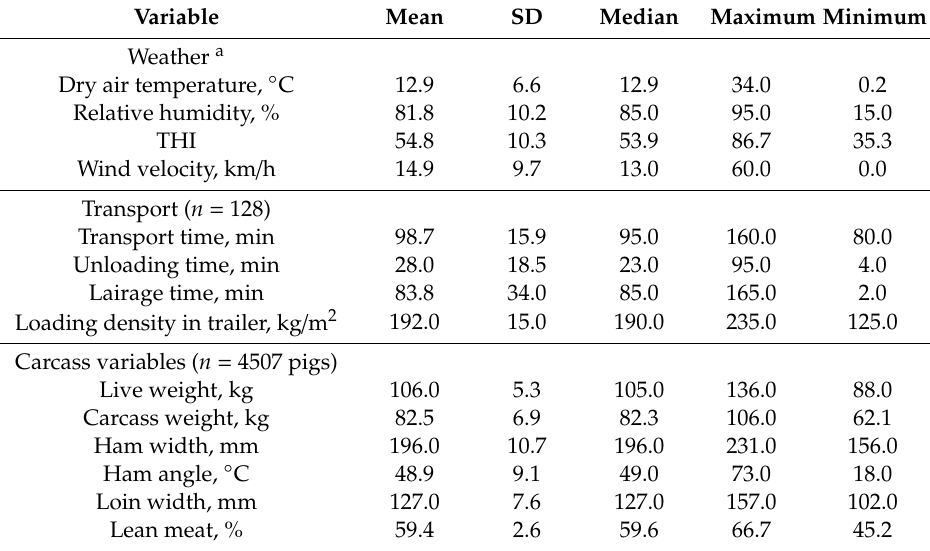
Table 2. Weather, transport, and carcass